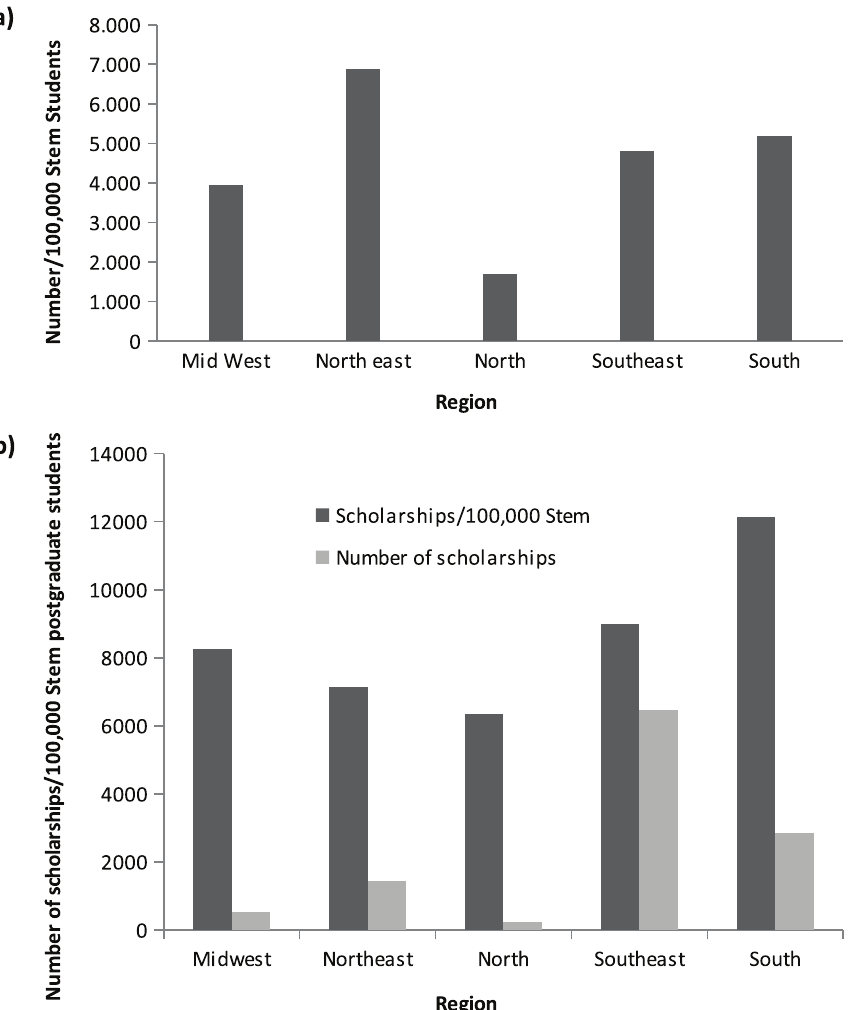
Figure 7 - Number of SwB scholarship holders per 100.000 students in Stem/SwB areas for different regions of Brazil for a) undergraduate and b) sandwich doctorate scholarships (from the Capes postgraduate